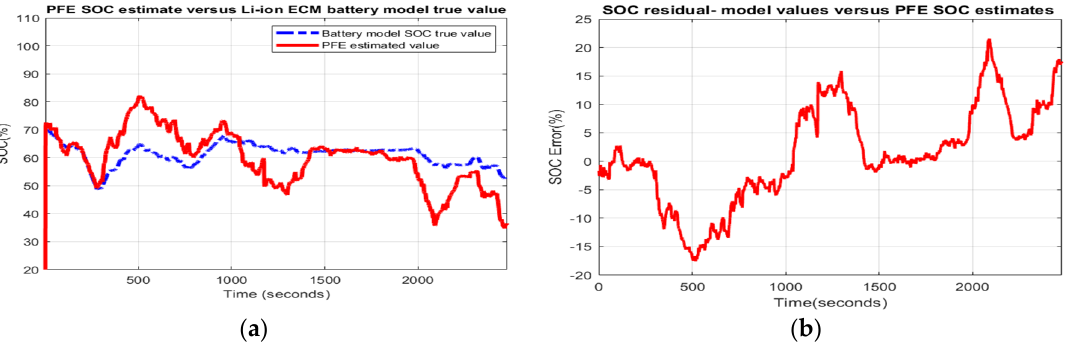
Figure 11. Robustness to simultaneous changes, SOCini = 0.2, and output temperature profile changes; ( a ) PFE SOC value versus 3RC ECM Li-ion battery model true value for changes only in Rin; ( b ) SOC residual for 20% changes in Rin.